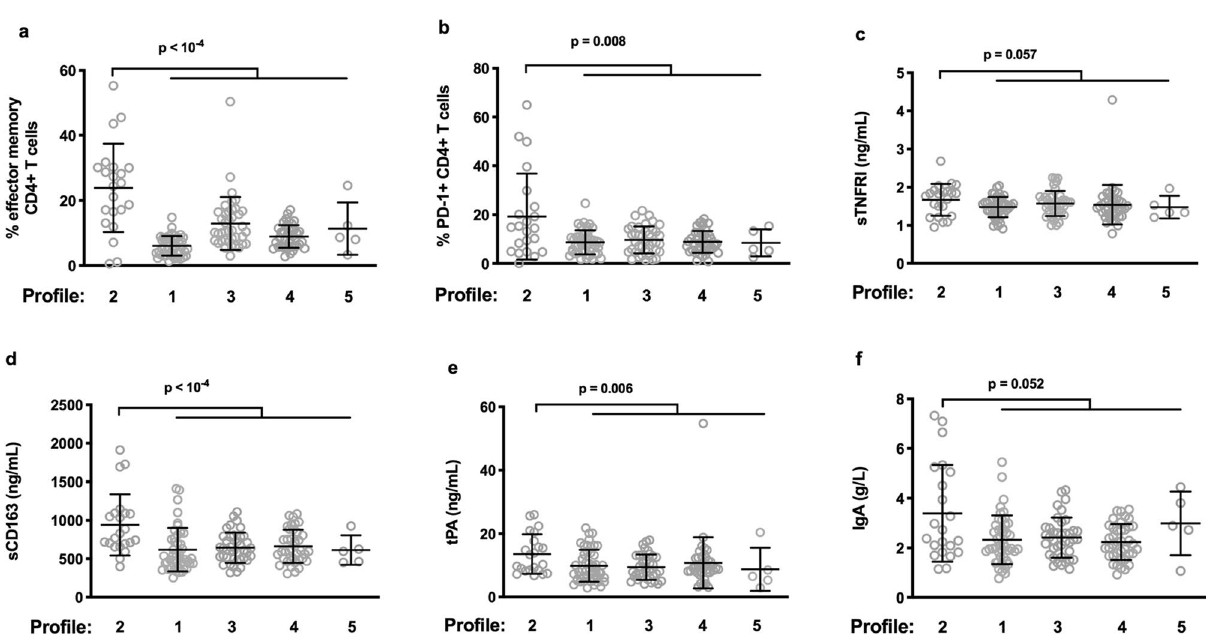
Figure 2. Immune characteristics of Profile 2. Differences between the level of various activation markers in Profile 2 and the other profiles ( a – f